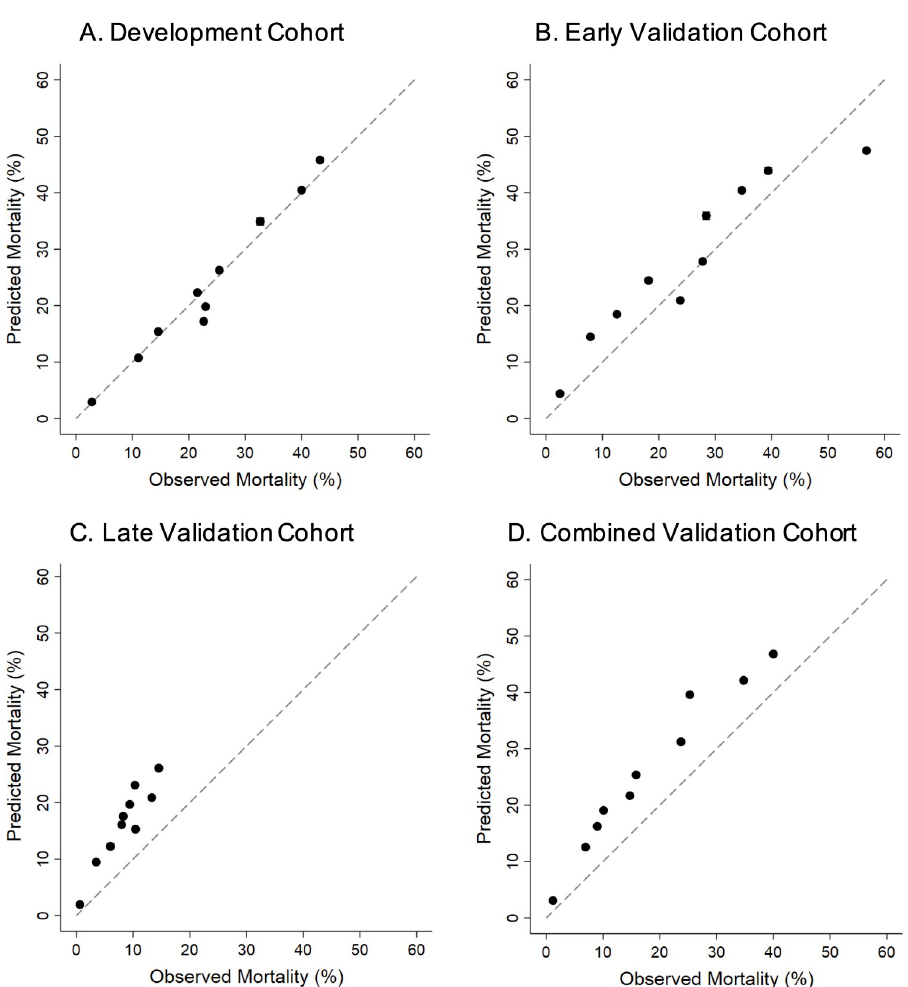
Fig 3. Calibration plots of VACO Index: Development, early validation, late validation, and combined validation cohorts. Calibration plots of VACO Index predicted 30-day mortality risk versus observed patient mortality across the cohorts. Error bars show 95% confidence intervals and dashed lines indicate perfect agreement between predicted versus observed patient mortality. a. Development cohort: test positive between March 2 and April 15, 2020, n = 3,681, 480 deaths. b. Early validation cohort: test positive between April 16 and May 18, 2020, n = 2,151, 253 deaths. c. Late validation cohort: test positive between May 19 and July 18, 2020, n = 7,491, 403 deaths. d. Combined early and late validation cohorts: test positive between April 16 and July 18, 2020, n = 9,642, 656 deaths.